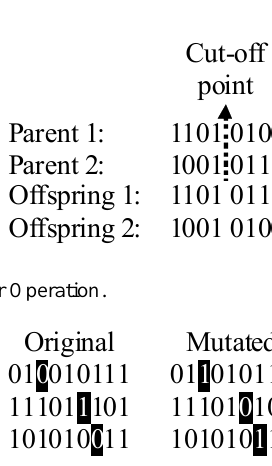
Fig. 5. Sample mutation operations. Figure 5. Sample mutation operations